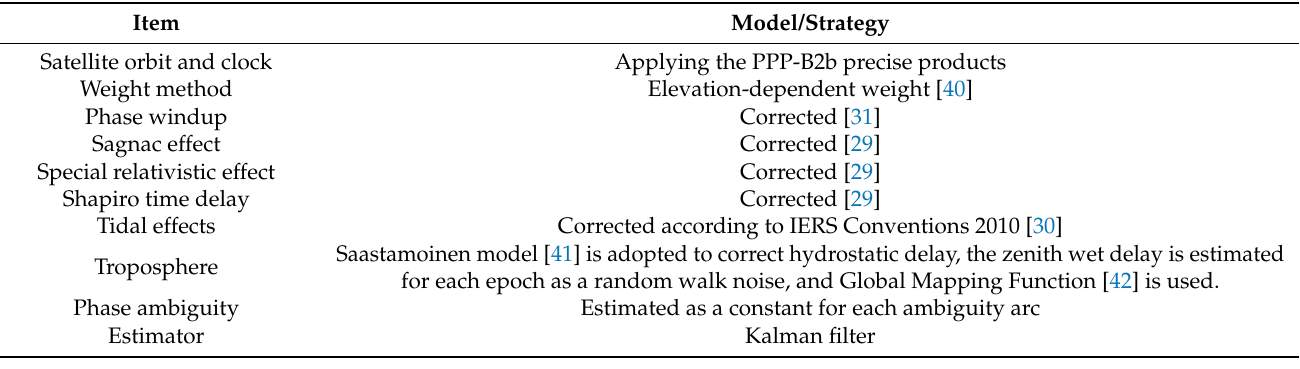
Table 2. Strategies of PPP-B2b